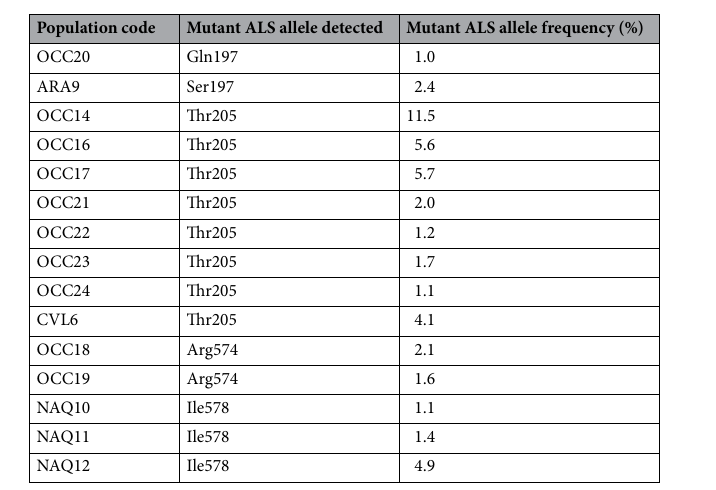
Table 1. Mutant ALS alleles detected by Illumina Pool-seq and their estimated within-population frequencies in a random sampling of 213 populations. Only populations where mutant alleles were detected are listed in this table.